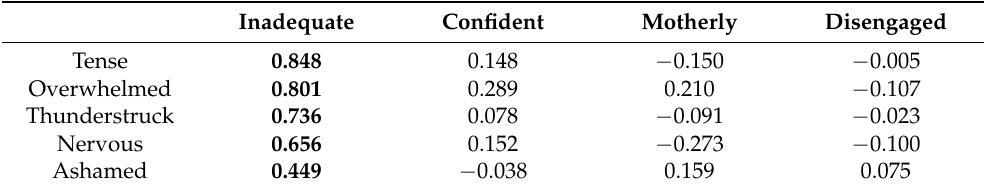
Table 2. The Feeling-Word Checklist—28: pattern matrix obtained via promax rotation showing the unique relationships between each factor and each observed